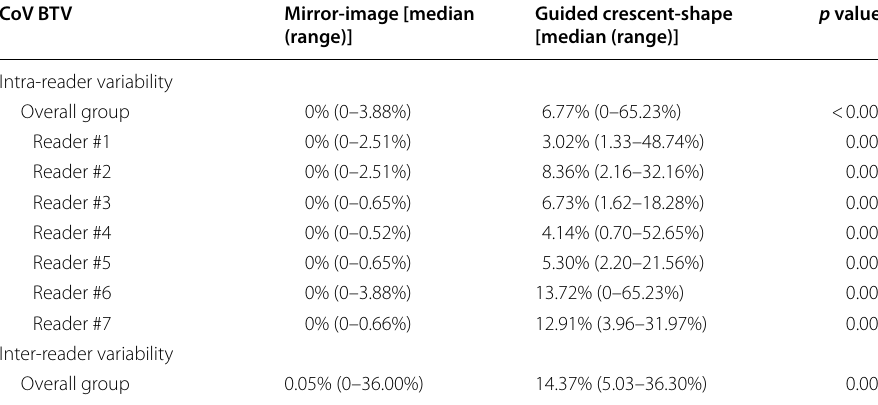
Table 2 Intra- and inter-reader coefficient of variation of the BTV CoV BTV